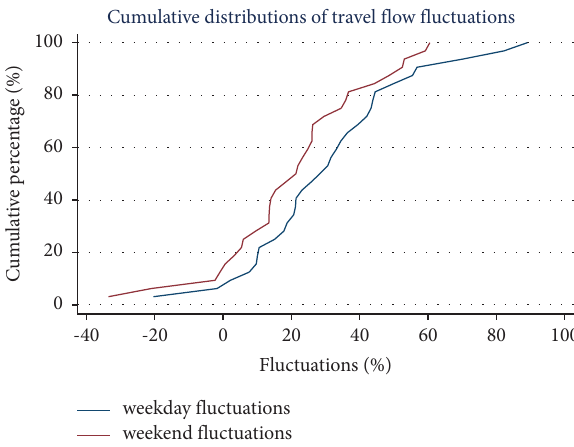
Figure 3: Cumulative distribution of average weekday and weekend travel fow fuctuations.